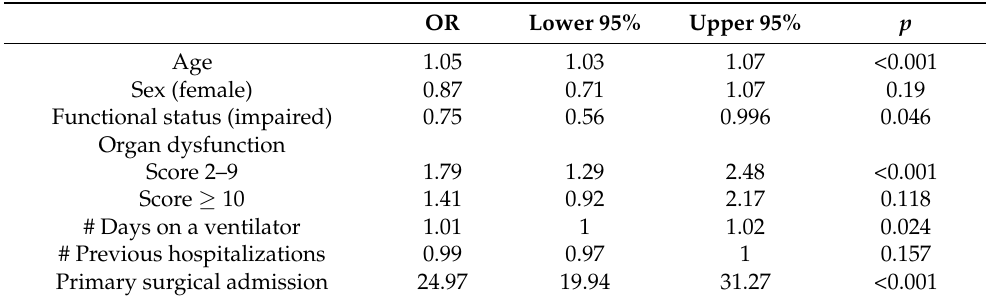
Table 4. Binary logistic regression model for total sample estimating effects of clinical and demo- graphic factors on receipt of opioid at PICU discharge.